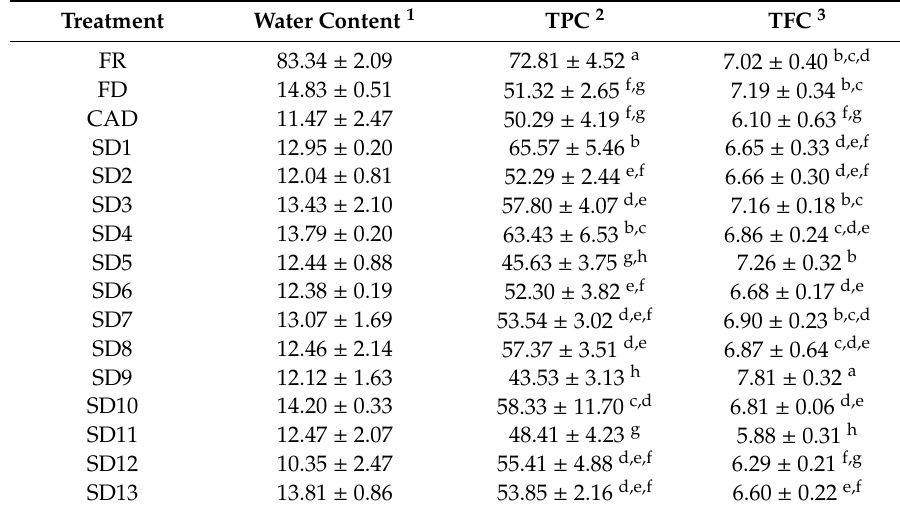
Table 1. Water content, total phenolics content (TPC), and total flavonoids content (TFC) of frozen and dried chokecherries.